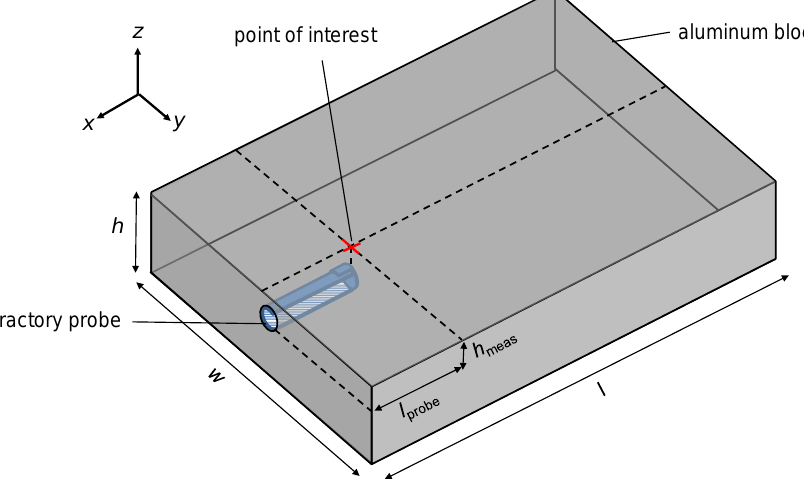
Figure 3. Schematic of the weld sample design with l = 60 mm, w = 40 mm, and h = 10.5 mm. The length of the probe was set to l probe = 8 mm, whereas the z -position of the probe beneath the sample surface was meant to be varied in order to enable the measurement of a depth-dependent temperature profile. In this setup, the z -position of the probe was fixed to h meas = 4 mm.